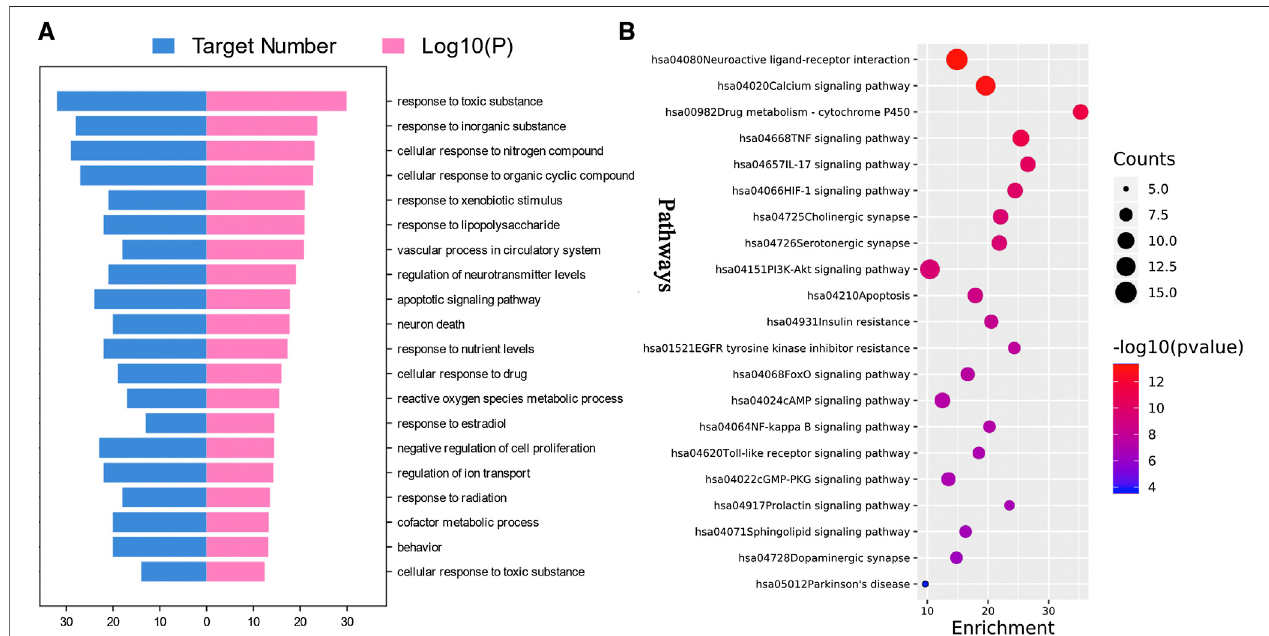
FIGURE 2 | Enrichment analysis of putative targets of Paeonia lacti fl ora P. for Parkinson ’ s disease. (A) Top 20 Gene Ontology biological processes. (B) Top 20 KyotoEncyclopediaofGenesandGenomes(KEGG)pathwaysandParkinson ’ sdiseasePathway.Sizeofthebubblestandsforthenumberoftargetsinthepathwayand the color stands for p value. The red bubble represents a smaller p value. ( p <